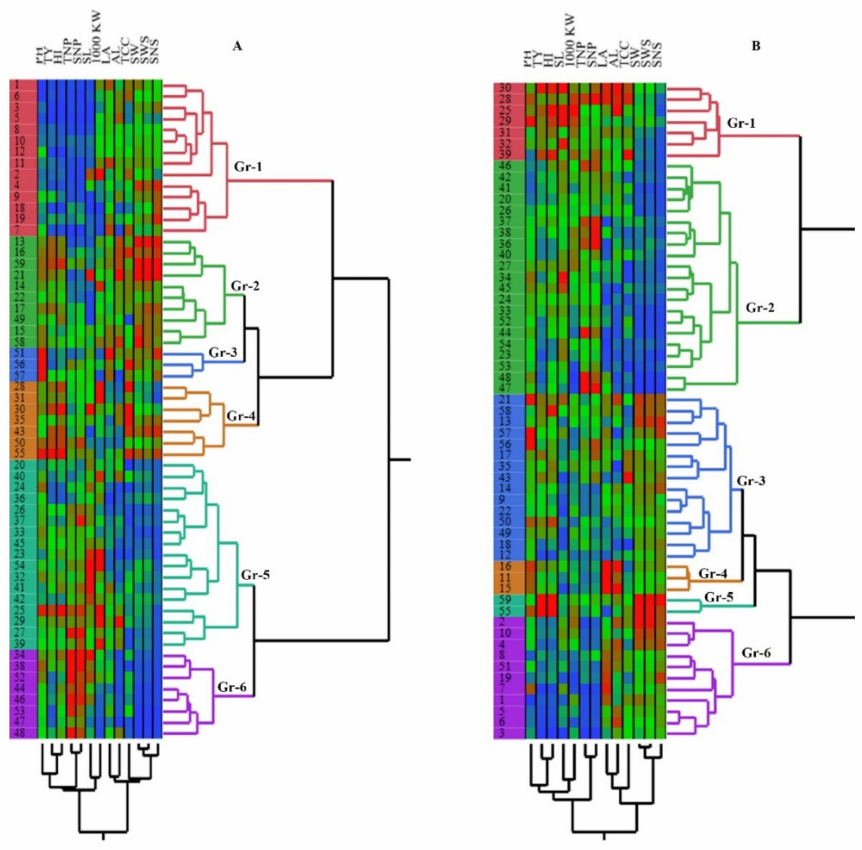
Figure 1. Dendrogram showing association among the 59 studied barley accessions and 13 measured morphological traits under both untreated (control) condition ( A ) and moringa plant extract foliar application ( B ). PH: plant height, LA: leaf area, TCC: total chlorophyll content, TNP: number of the tiller per plant, SNP: number of the spike per plant, SL: spike length, AL: awan length, SW: spike weight, SNS: number of seeds per spike, SWS: seed weight per spike, 1000-KW: 1000-kernel weight, TY: total yield per plot, STW: straw weight per plot. The numbers (1–59) denote the barley accessions. The number of formed groups ranges from Gr-1 to